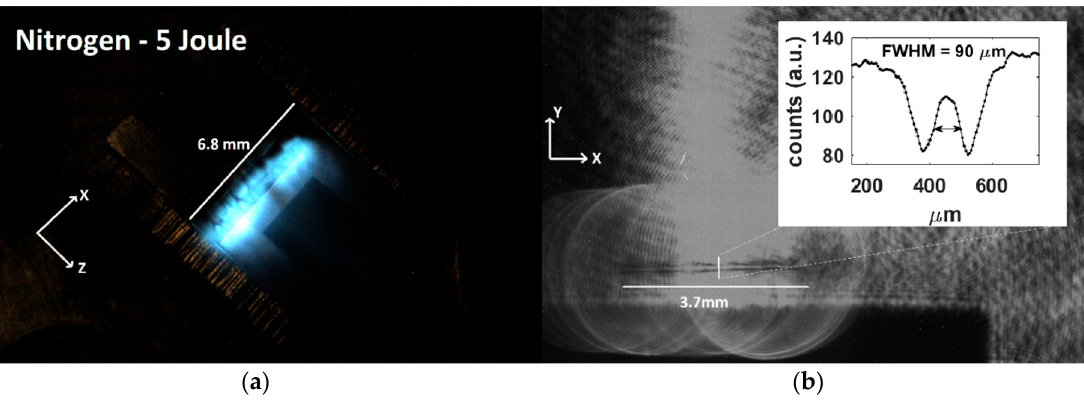
Figure 8. Experimental measurements obtained with N at 64 bar and 5 J. ( a ) Top view of the gas-nozzles and optical plasma emission; ( b ) shadowgraphy of the plasma channel and inner diameter measurement.